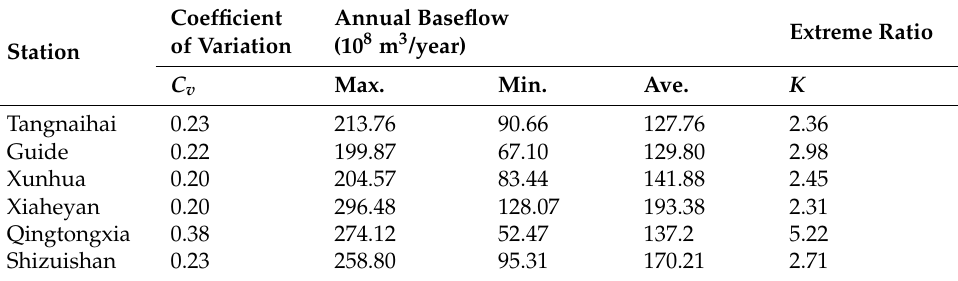
Table 2. Statistics of baseflow characteristics in the study